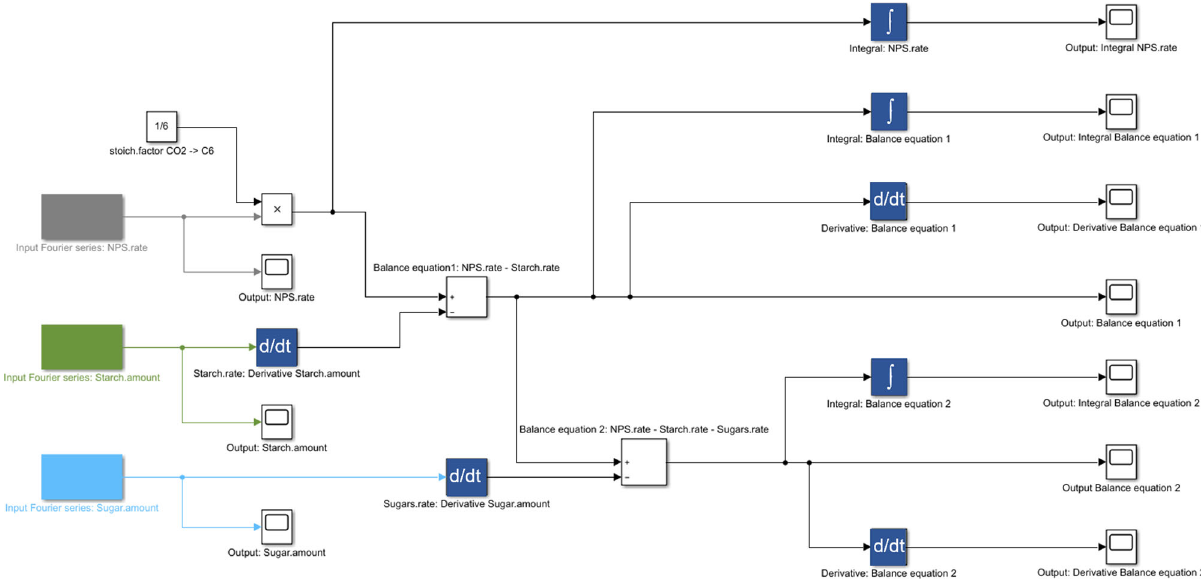
Fig. 1 Block diagram applied for Fourier polynomial balance modeling. Input functions are marked in gray (NPS), green (starch amount), and light blue (sugar amount) colored blocks (left side). Arrows indicate the direction of fl ux and connect input blocks via multiplication ( “ x ” ) summation ( “ + /- “ ), differentiation ( “ d/d t ” ), and integration ( “ ∫ ” ) with output